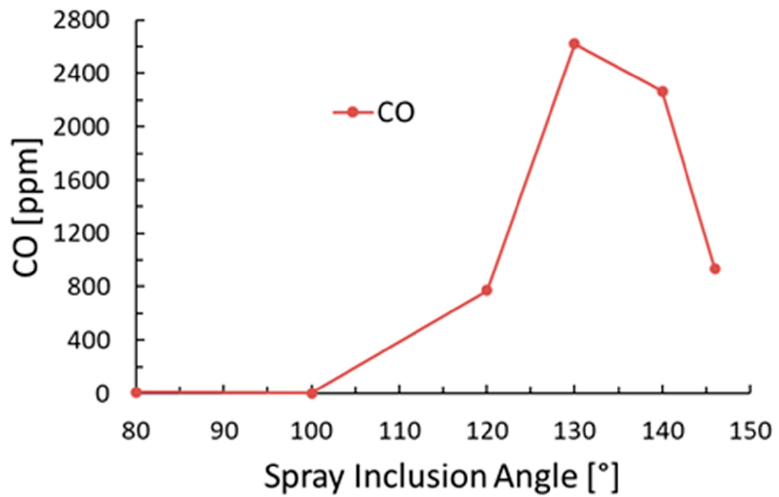
Figure 40. CO emission characteristics of various SIAs. CE and IMEP for various SIAs are presented in Figure 41. For wide SIA cases of 146 ◦ , 140 ◦ , and 130 ◦ , CEs are 84.3%, 78.9%, and 81.5%, respectively; while for narrow SIA cases of 120 ◦ , 100 ◦ , and 80 ◦ , CEs are 91.3%, 97.8%, and 96.3%, respectively. CE severely deteriorates due to incomplete combustion of the inadequately mixed fuel vapor with air at low temperatures for wide SIA cases. The lowest CE of 78.9% occurs for the SIA of 140 ◦ due to incomplete rich combustion of the poorly mixed fuel vapor with air in both the squish region and crevice at flame temperatures ranging between 1500 K and 2000 K after spray impingement on the cylinder liner.